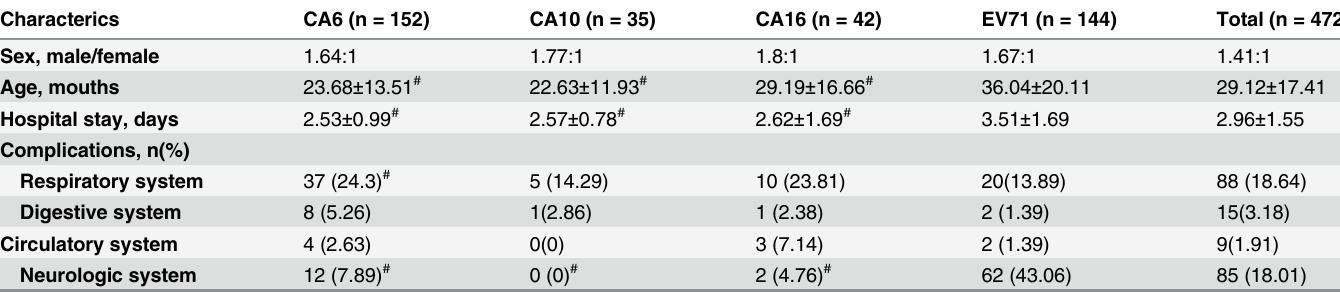
Table 1. Demographics Features and diagnoses of HFMD patients.